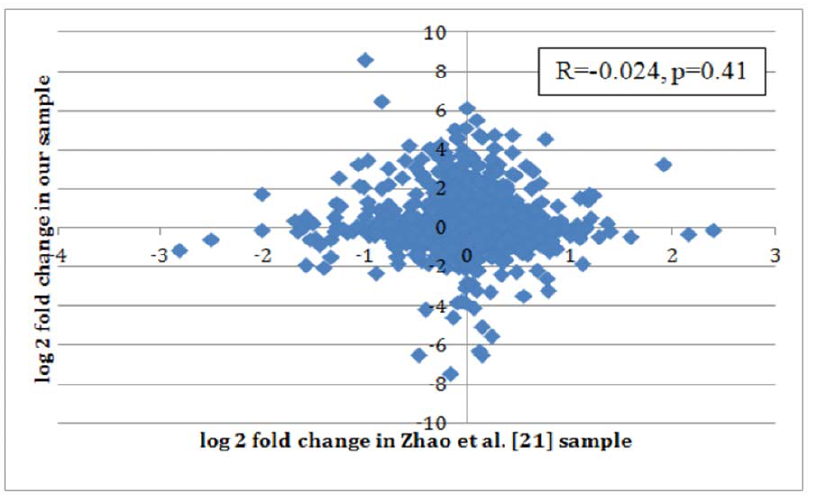
Figure 2. Lack of global correlation in fold change between our and Zhao et al. datasets. Correlation in fold change for all miRNAs between breast cancer cases and controls observed in our and Zhao et al. sample sets. The one agreeing data-point (up in both) is miR-431*, p=0.15 in ours, p=0.03 (unadjusted) in Zhao et al.